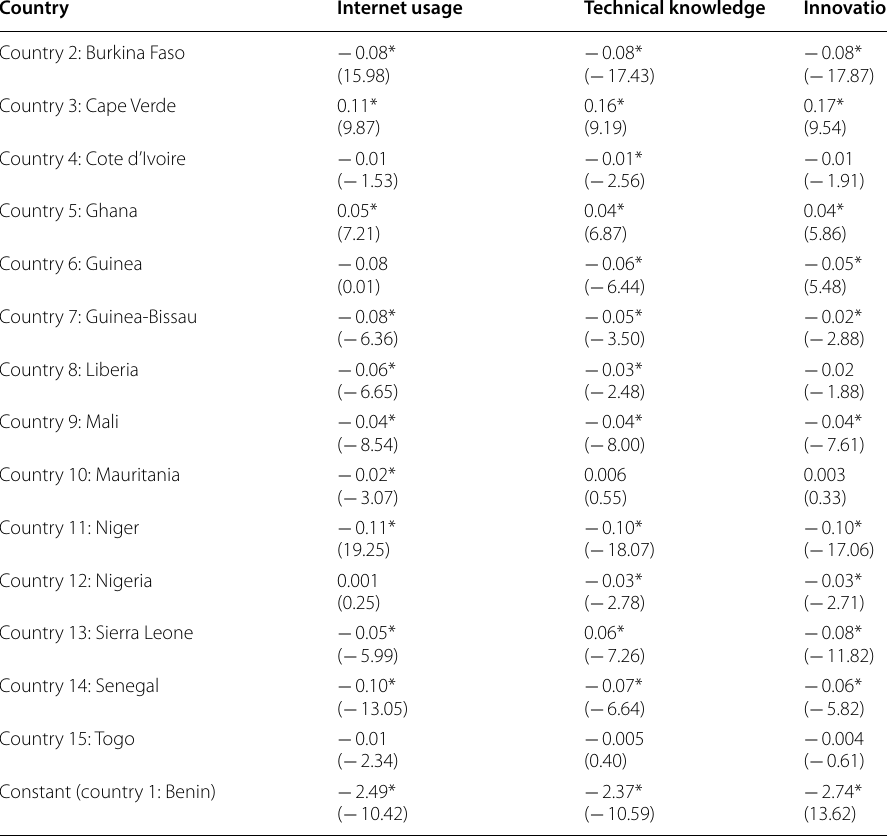
The values are approximated to 2 decimal places to make the table compact; the values in the parentheses ‘()’ are the t statistic; *denotes that the coefficients are significant at 5% level